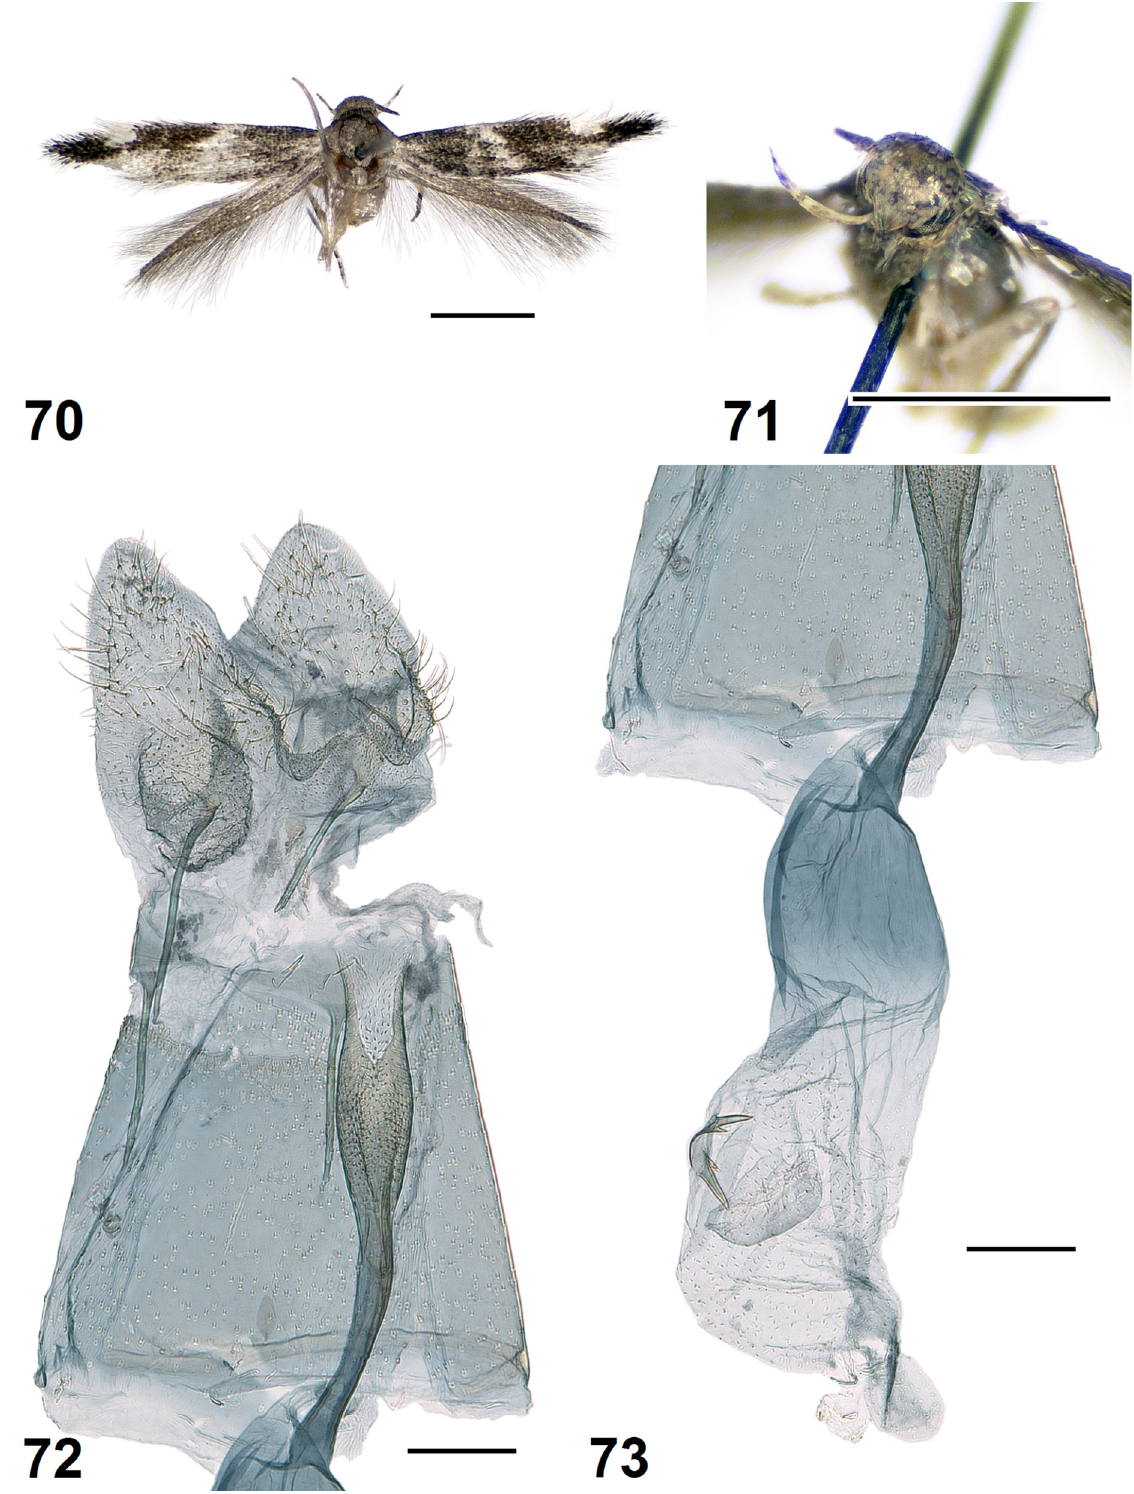
Figs 70–73. Elachista siamensis Sruoga & Kaila sp. nov., paratype, ♀ (ZMUC 2075). 70 . Adult. 71 . Head, latero-frontal view. 72 . Female genitalia, caudal part. 73 . Ductus and corpus bursae. Scale bars: 70–71 = 1 mm; 72–73 = 0.1